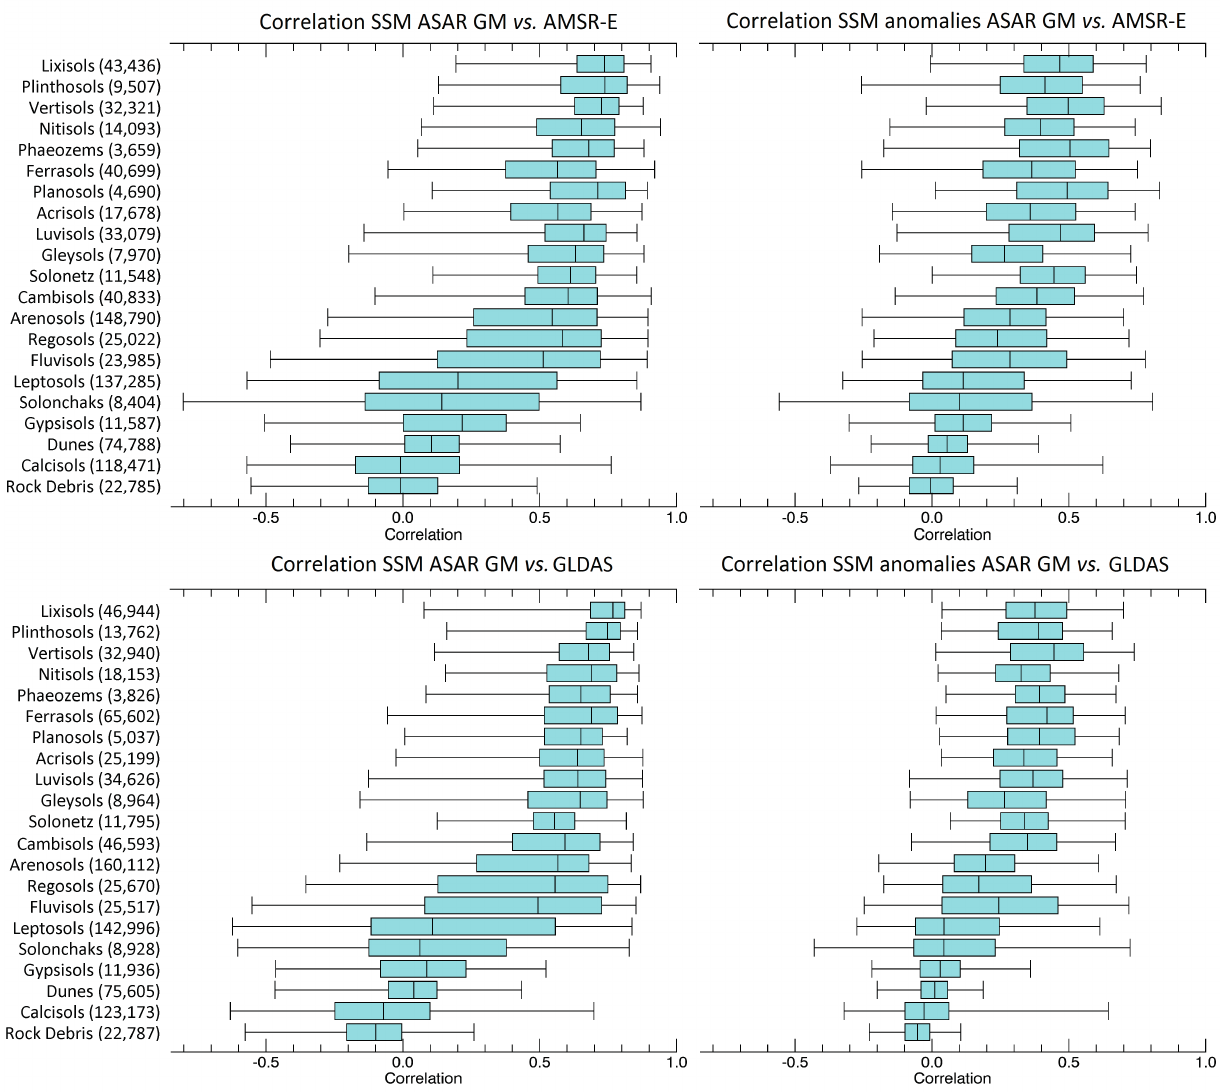
Figure 6. The box-plot representation of the correlation results stratified by the Harmonized World Soil Database soil types. The boxes show the median, 25th and 75th percentiles; the lines represent minimum and maximum values after outlier removal (first and 99th percentile). The amount of 5-km Advanced Synthetic Aperture Radar (ASAR) pixels used for the evaluation for each class is shown in brackets behind the class name. ( Left ) Original Surface Soil Moisture (SSM) values; ( Right ) SSM anomalies. ( Top ) ASAR Global Monitoring (GM) mode vs. Advanced Microwave Scanning Radiometer for Earth Observing System (AMSR-E); ( Bottom ) ASAR GM vs. the Noah model from the Global Land Data Assimilation System